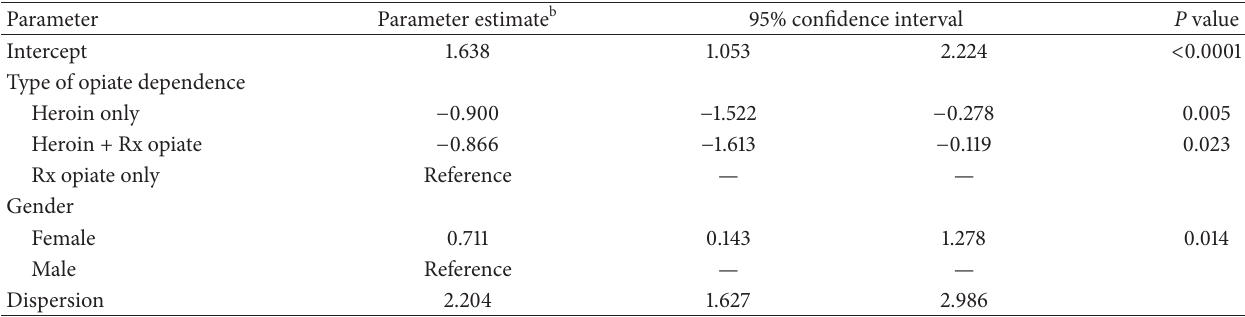
Table 1: Multivariate a negative binomial regression predicting the total number of prescriptions for controlled substances filled in the 2 years prior to presenting for outpatient medication-assisted treatment for opiate dependence.